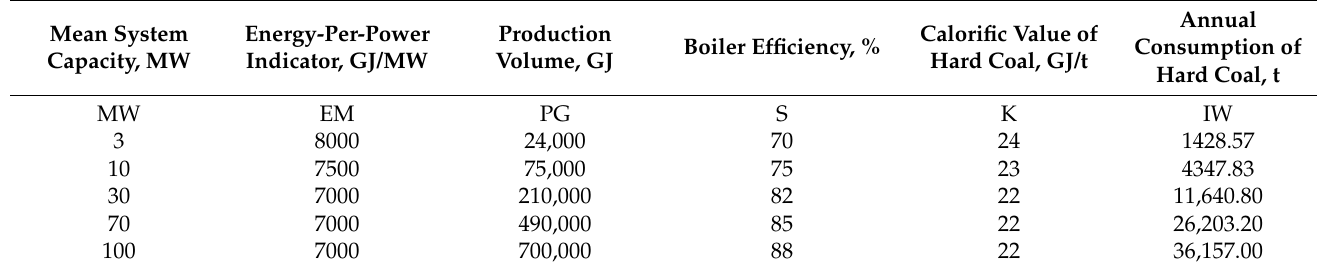
Table 2. The annual energy production volume and hard coal consumption for systems with a capacity ranging from 3 MW to 100 MW. Mean